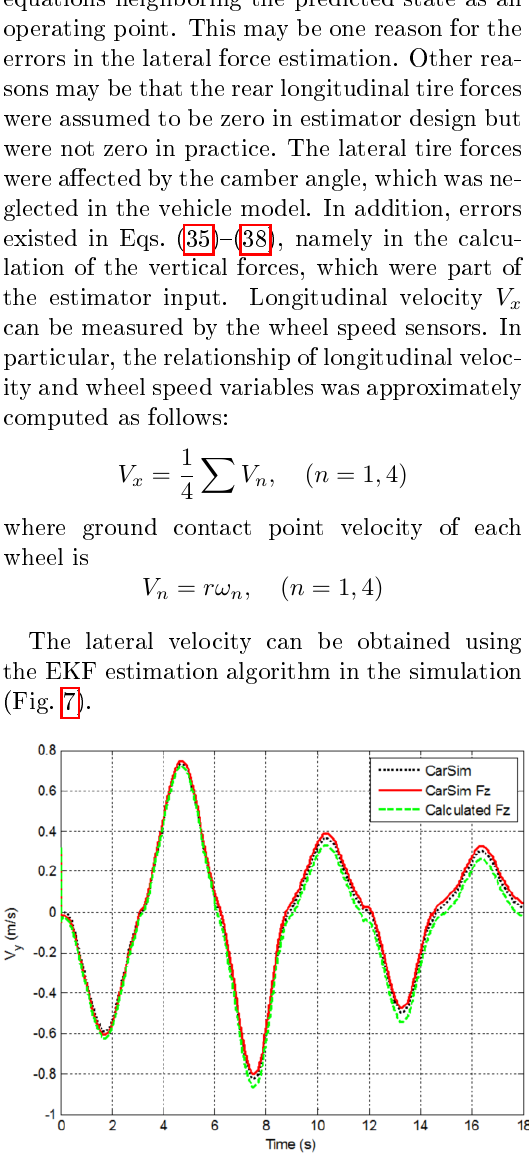
Fig. 7: Estimation of the lateral velocity.